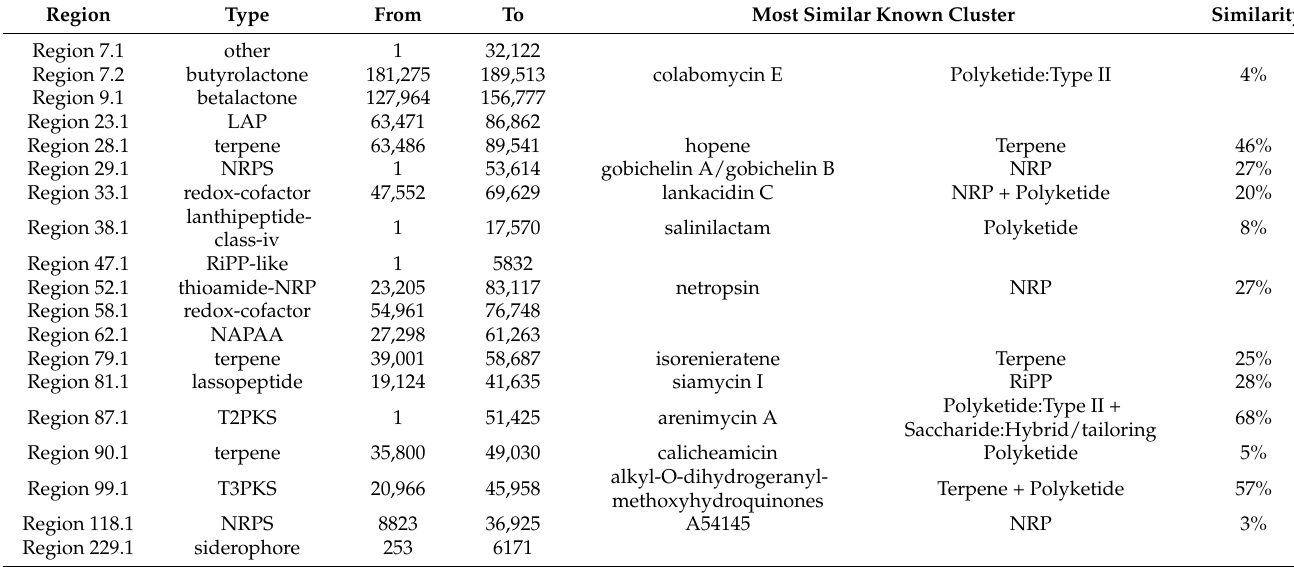
Table A11. Dactylosporangium sp. AC04546 secondary metabolite biosynthetic gene clusters (BGCs) were predicted using AntiSMASH